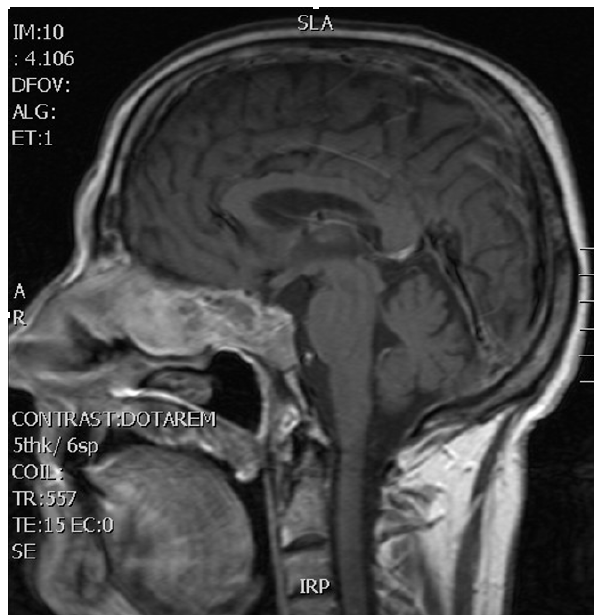
Fig. 5. Postoperative MR with contrast agent, T1 weighted im- age. Withouth any sign of meningocoele, wound is closed using muscle, adipose tissue, fascia lata, nasoseptal flap and tissue